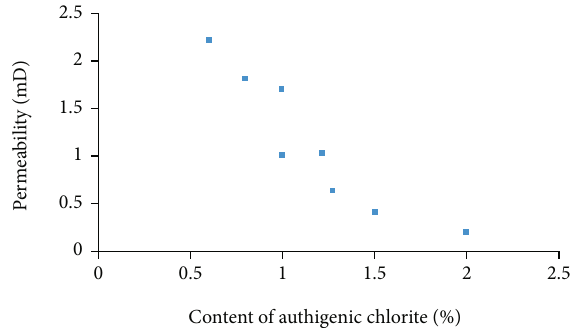
Figure 11: Diagram of relationship between the content of authigenic chlorite and